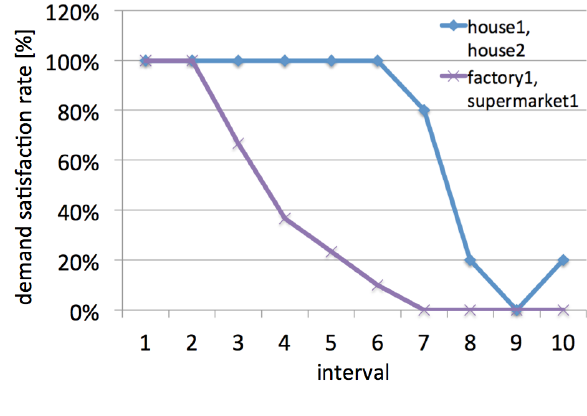
Figure 11. The transition of the demand satisfaction